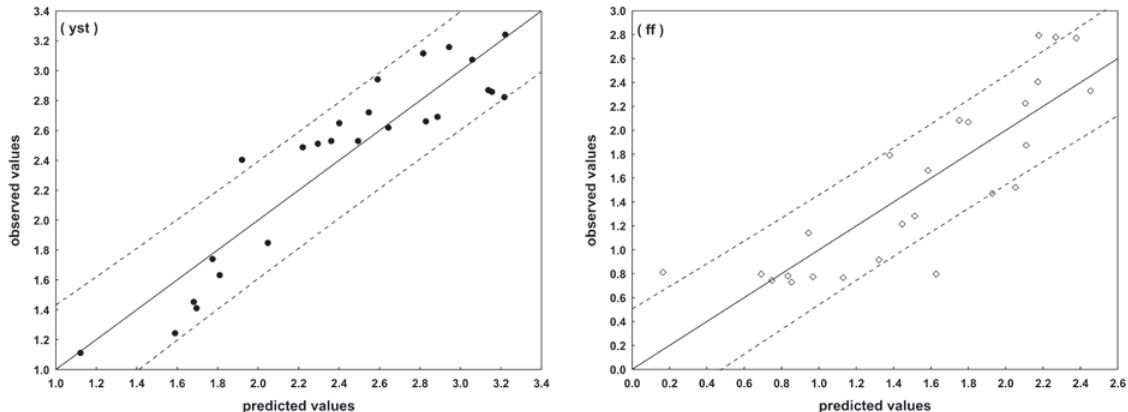
Figure 3. Graphical representation of observed values FA versus predicted FA given by Eqs. 3 yst and 3 ff together with the corresponding pre- dicted